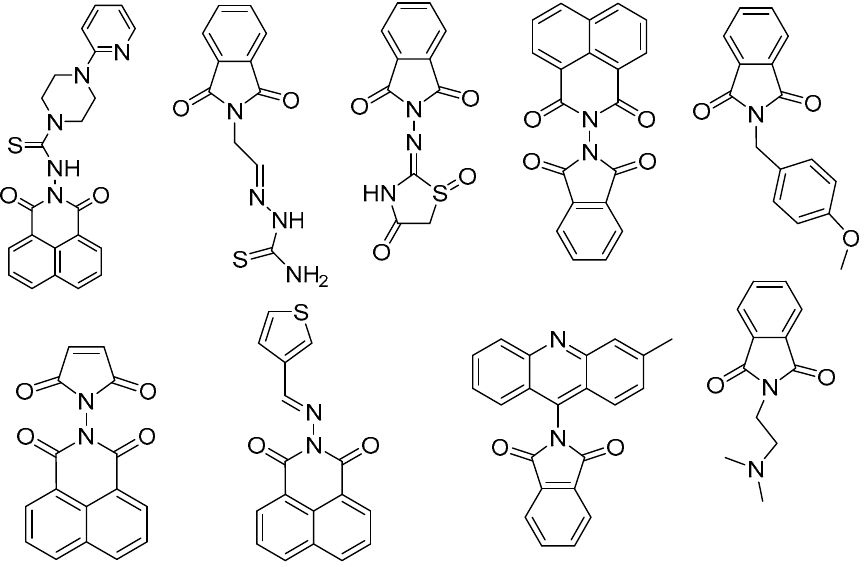
Figure 1. The reported bioactive cyclic anhydrides.